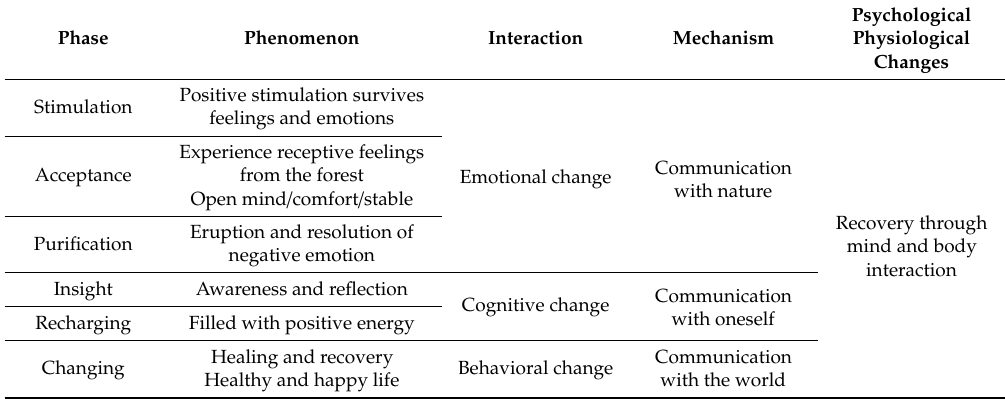
Table 4. Comprehensive analysis of nature-based therapy